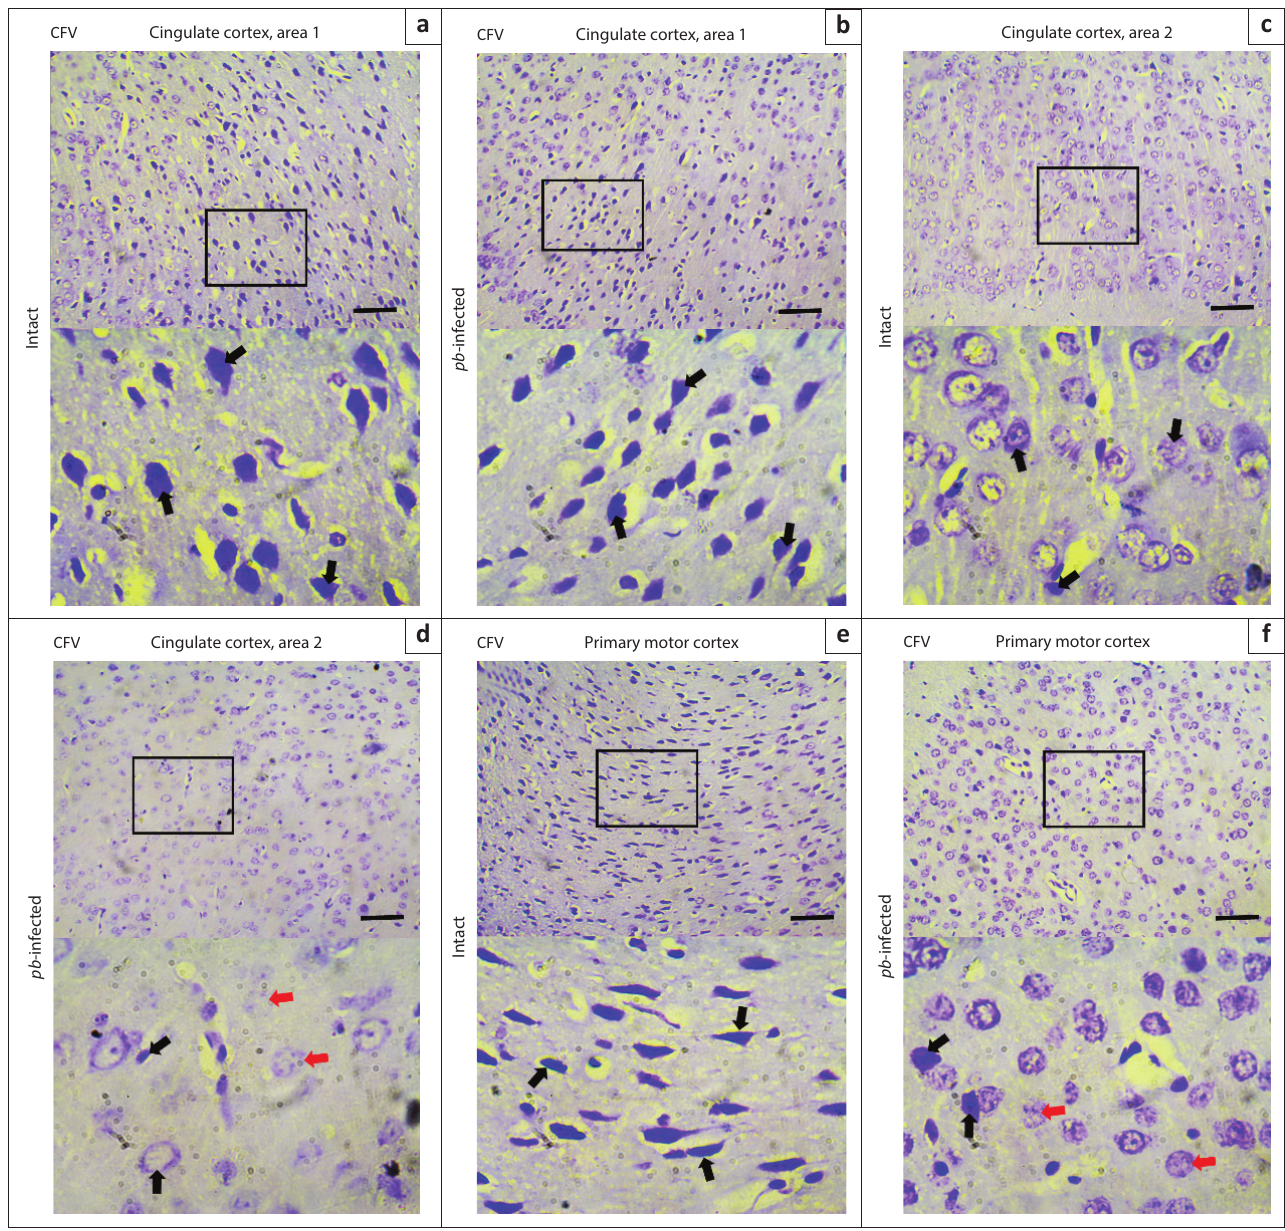
FIGURE 12: Neuronal population within the midline of brain. (a) and (b) Cresyl violet-stained sections of cingulate cortex area 1 in intact and Pb -infected mice, respectively. (c) and (d) Nissl substance distribution in Cresyl violet-stained sections of cingulate cortex area 2 in intact and Pb -infected mice, respectively. (e) and (f) Primary motor cortex in intact and Pb -infected mice stained with Cresyl violet, respectively. Note, almost all the cell bodies stained remarkably (black arrow) although few of them appeared pale and assumed round-shaped (red